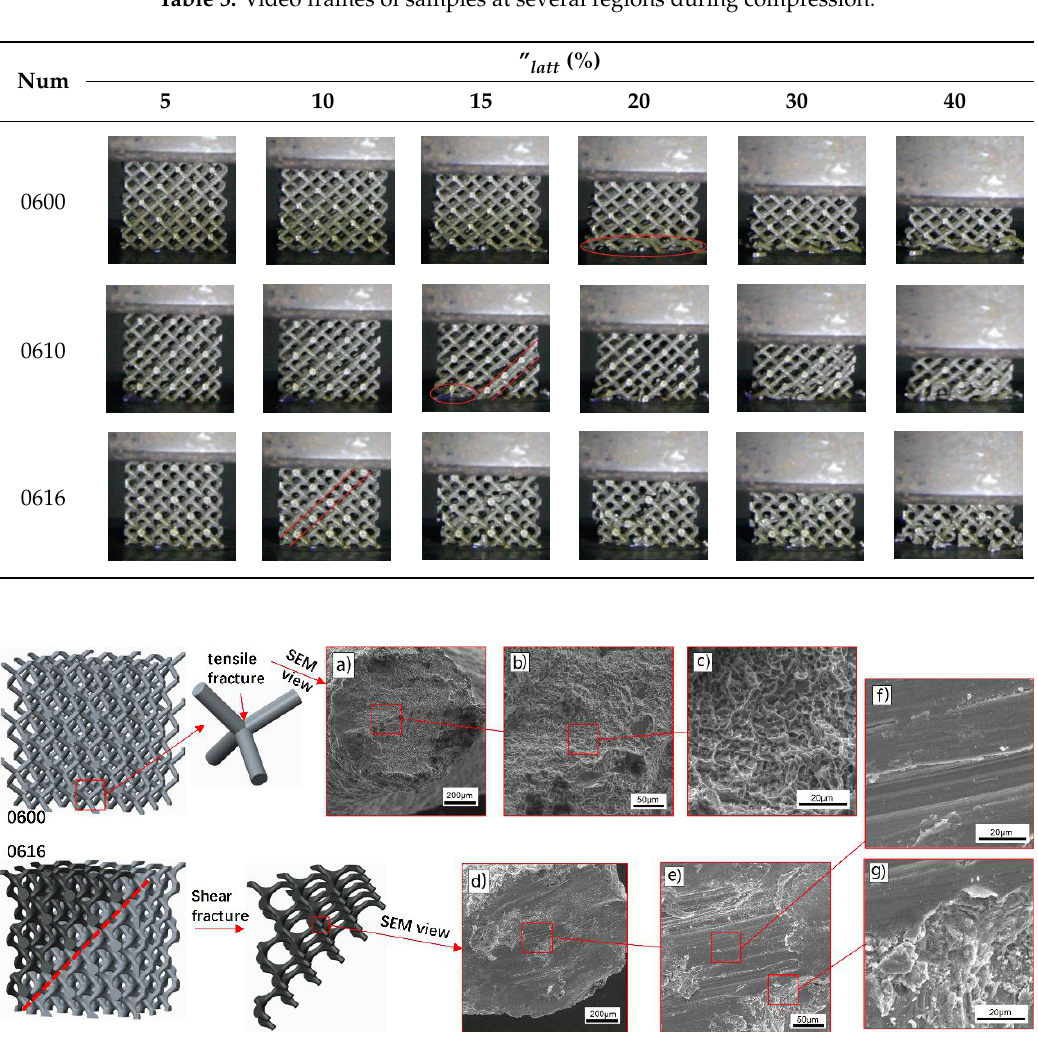
Figure 10. SEM morphologies of fracture surface: ( a – c ) tensile yield at node with ductile dimpling for sample 0600, ( d – g ) shear rupture at rod for sample 0616.